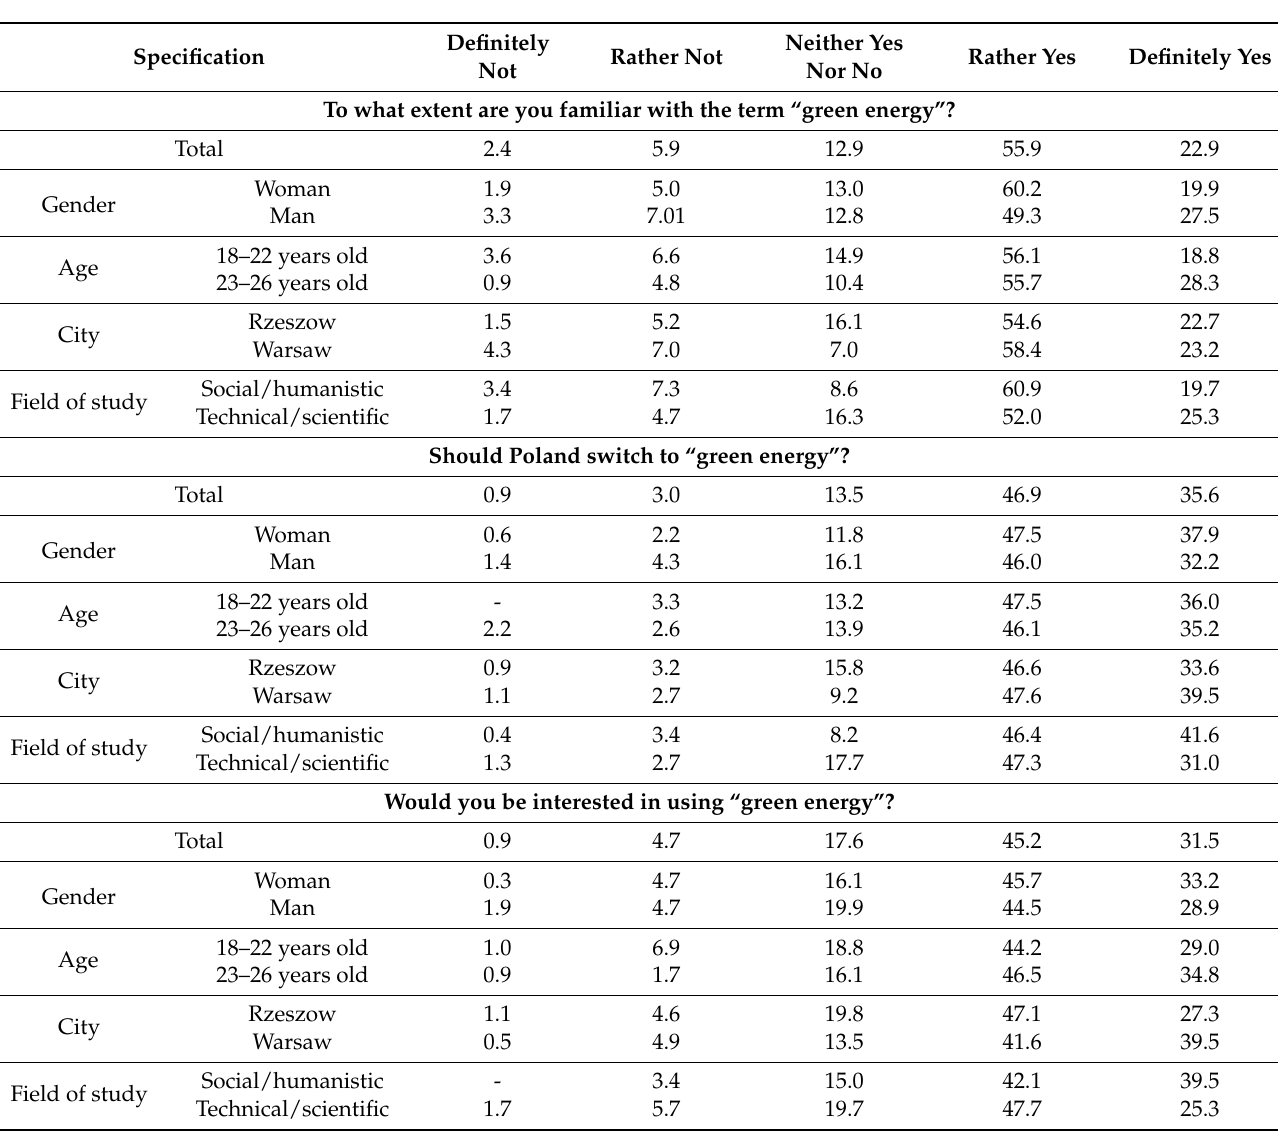
Table 7. Knowledge of green energy issues and its promotion among consumers of Generation